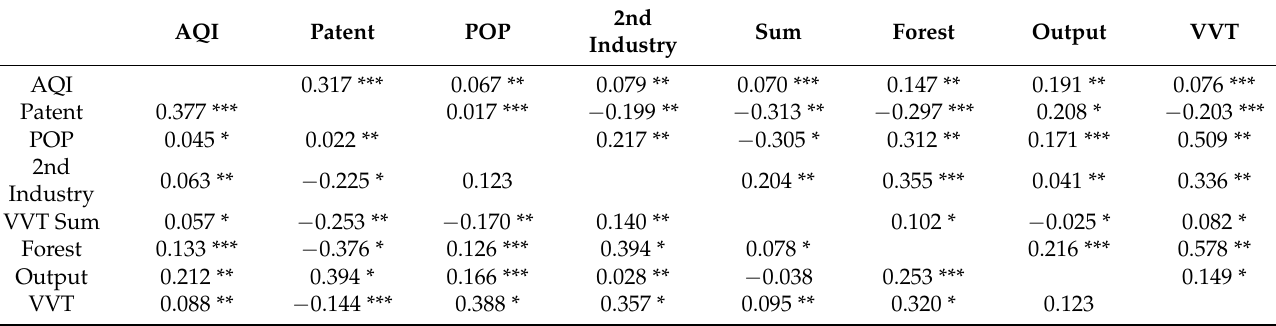
table and Spearman’s correlations on the top right corner. Table 2. Pearson’s correlations and Spearman’s correlations of